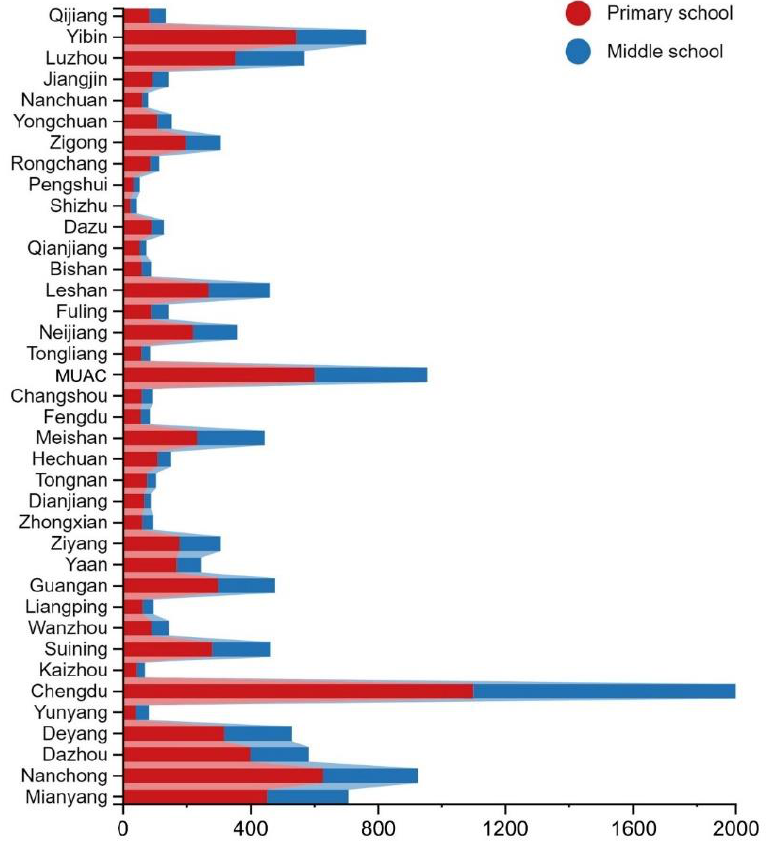
Figure 2. Number of PMSs in each study